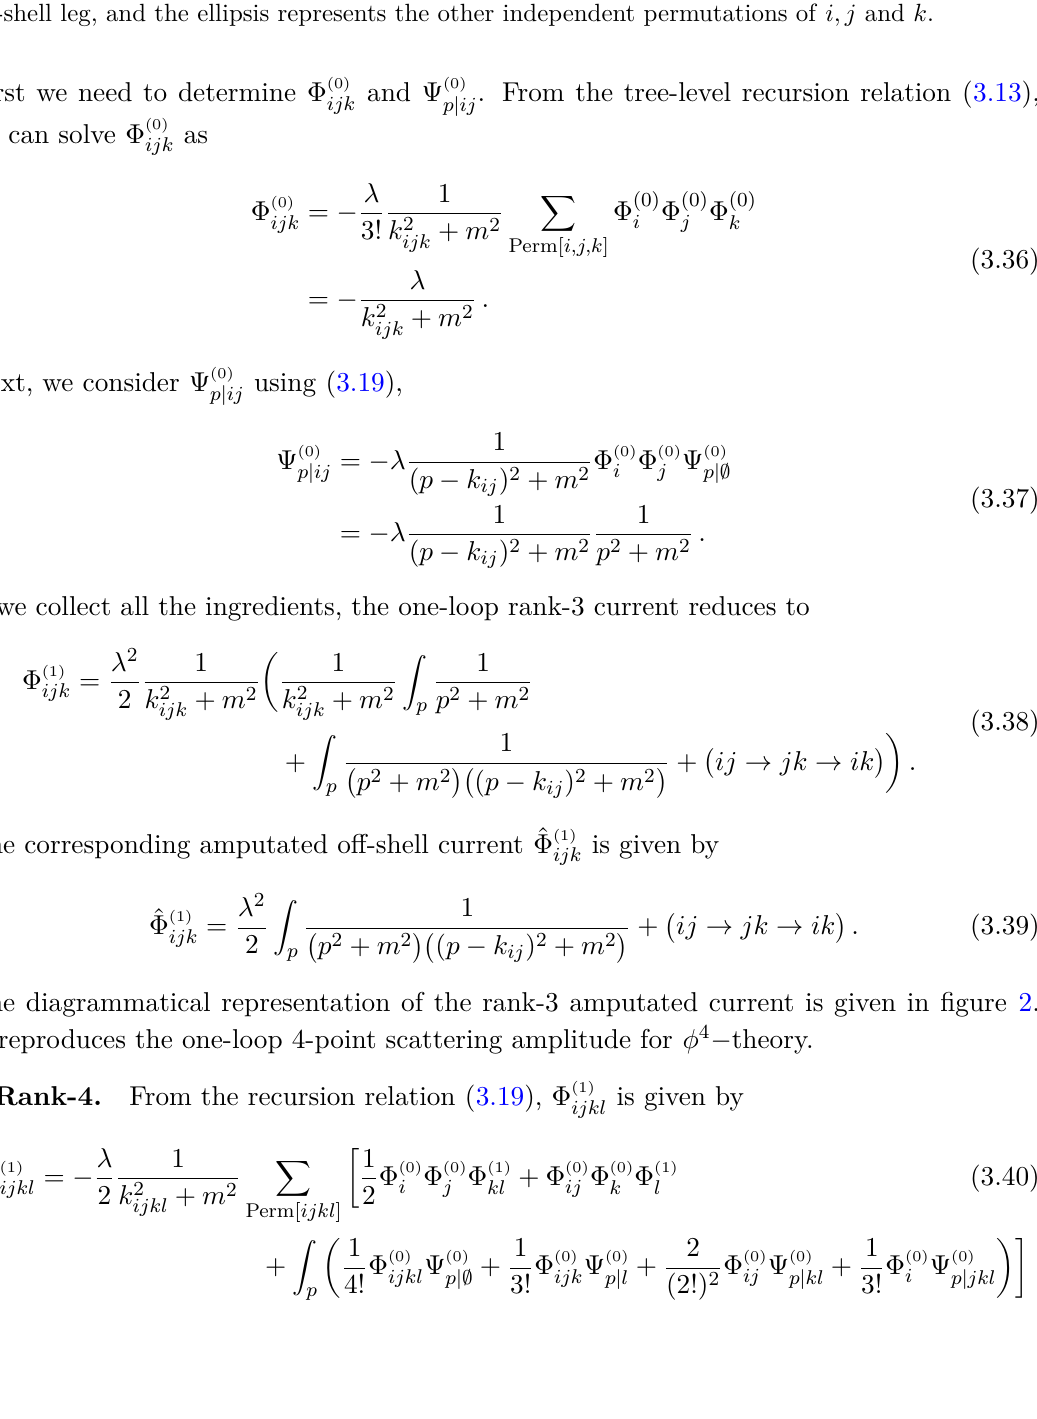
Figure 2 . One-loop rank-3 amputated off-shell currents. Here the thick line is the amputated off-shell leg, and the ellipsis represents the other independent permutations of i, j and k